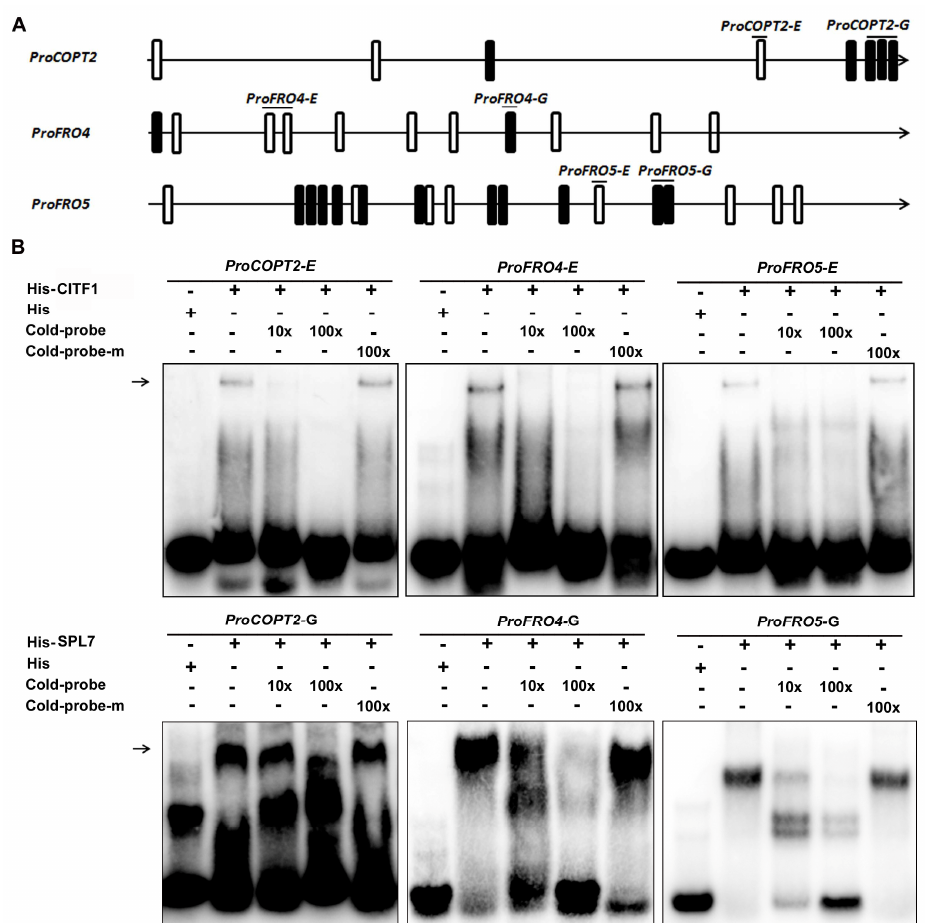
Figure 6. Both SPL7 and CITF1 bind to the promoters of COPT2 , FRO4, and FRO5 . ( A ) GTAC-boxes and E-boxes are indicated in the promoters. ( B ) EMSAs. Recombinant proteins indicated were incubated with the biotin-labeled probes. Biotin-probe, biotin-labeled probe; cold-probe, unlabeled probe; cold-probe-m, unlabeled mutated probe with mutated GTAC-boxes or